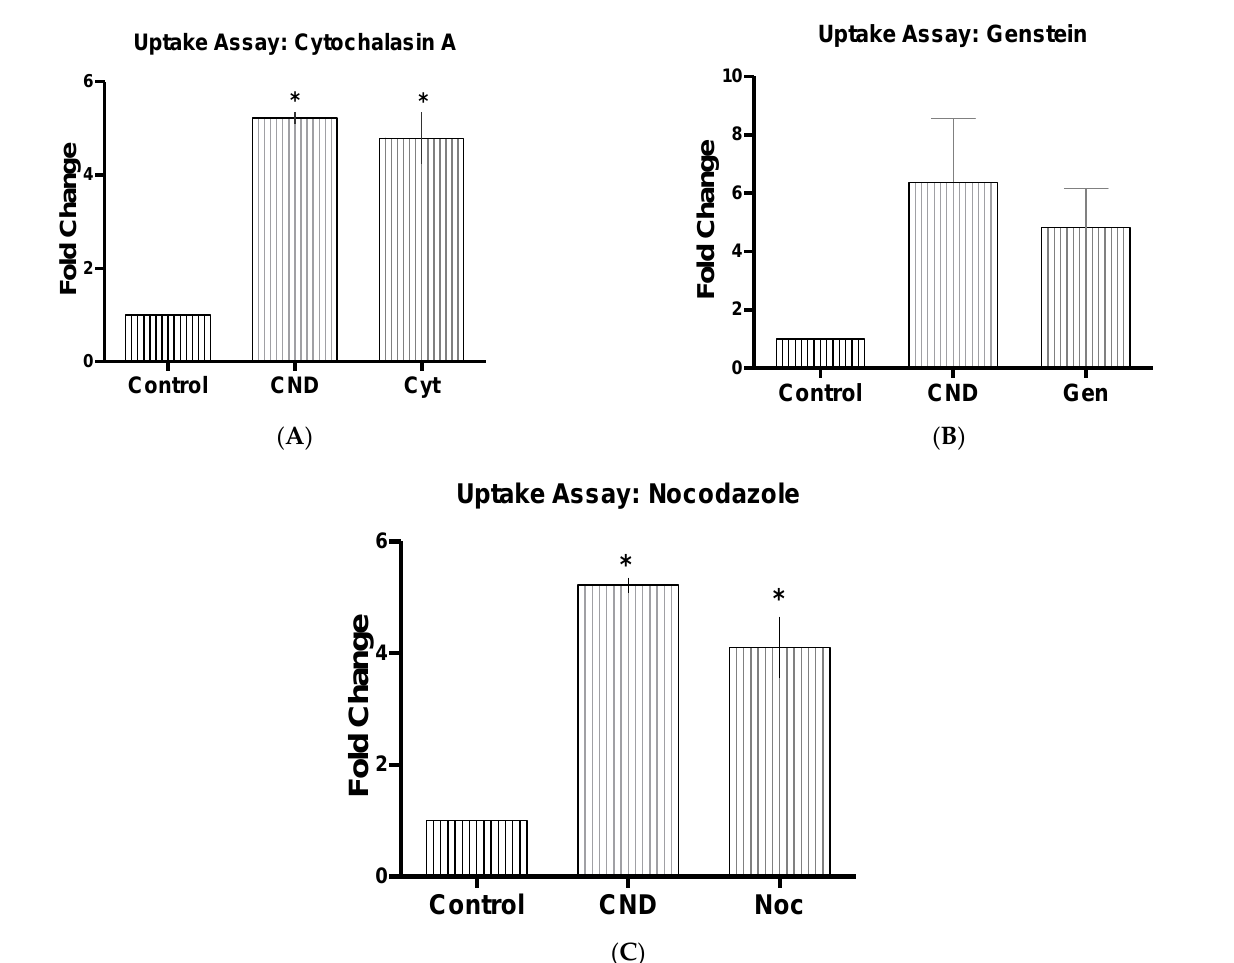
Figure 8. CND uptake with channel blockers HMEC-1 cells were treated with inhibitor 4-AP ( A ), Amil ( B ), Amio ( C ), Ant ( D ), Ba ( E ), Cs ( F ), Co ( G ), Cu ( H ),Eb ( I ), Hg ( J ), N-Ph ( K ), Nif ( L ) with concentrations described (Table 1), for 30 min. Cells were then washed two times with PBS and treated for 6 h with 0.1 mg/mL of CNDs. After CND treatment, cells were washed two times with PBS and removed. Cells’ fluorescence was checked using the Bio-Tek ® Synergy plate reader at 360/40 excitation and 460/40 emission. Channel blocking inhibitors displayed no significant change in fluorescent intensity. All data represent mean ± SEM. (n = 3–5, * p < 0.05 vs. Control).